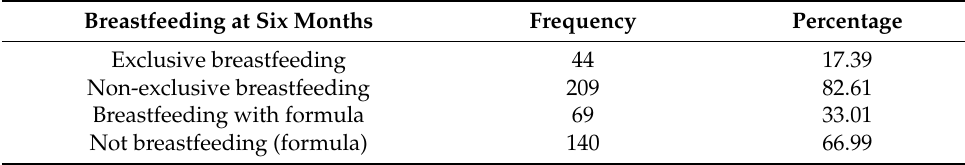
Table 1. Breastfeeding practice of adolescent mothers ( n =